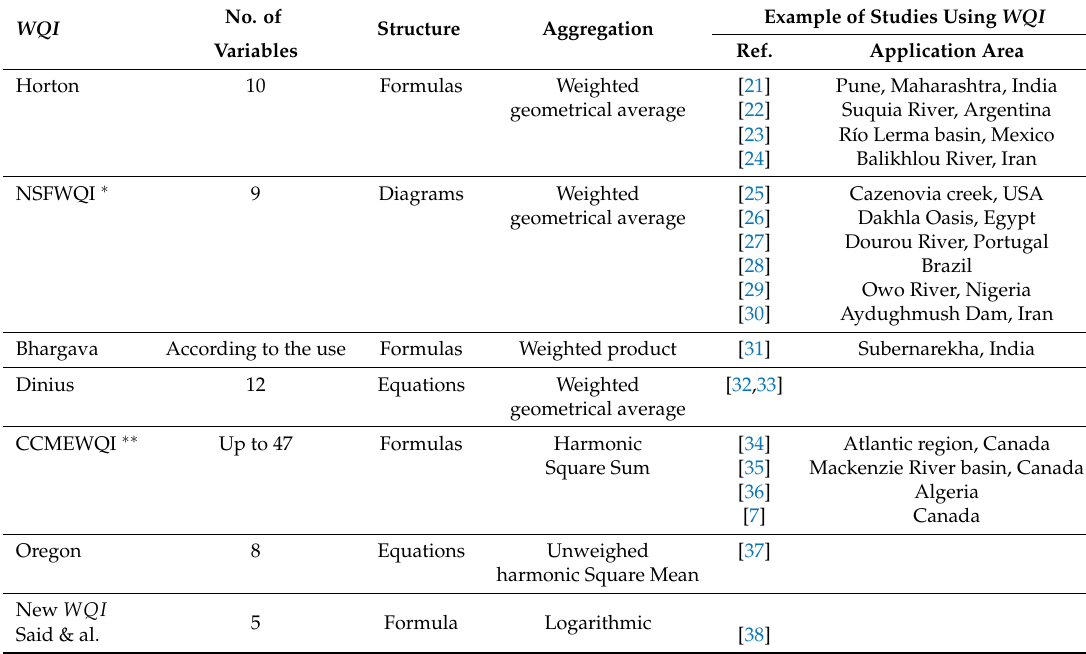
Table 1. Structure, aggregation formula and number of variables in Water Quality Index ( WQI ) and some references using